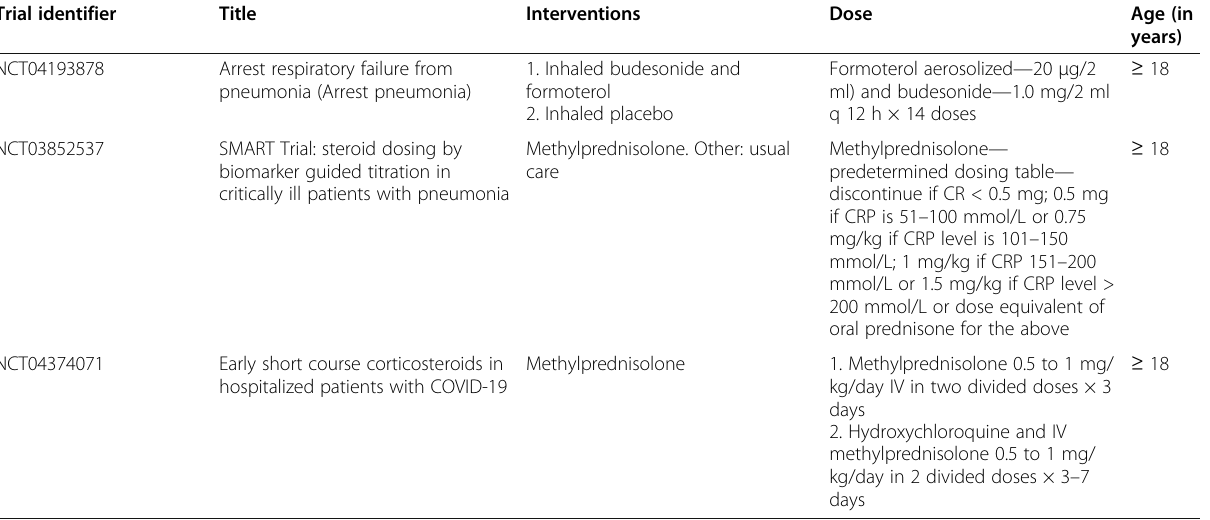
Table 3 Steroid treatment in patients with COVID-19 (Continued)